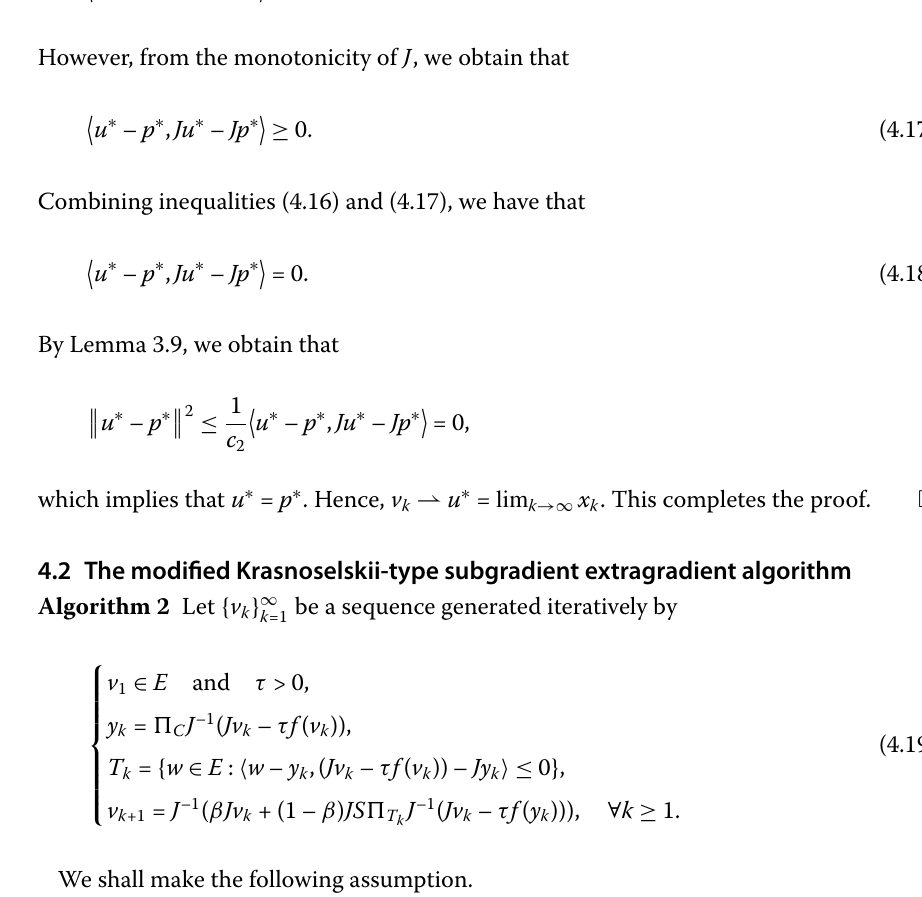
be a sequence generated iteratively k =1